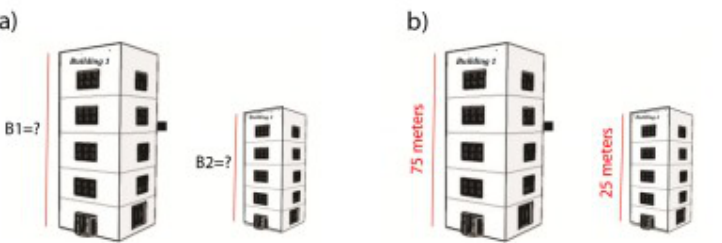
Figure 3. Remediaton for queston 2: a) used afer 1st unsuccessful atempt and b) used afer 2nd unsuccessful atempt